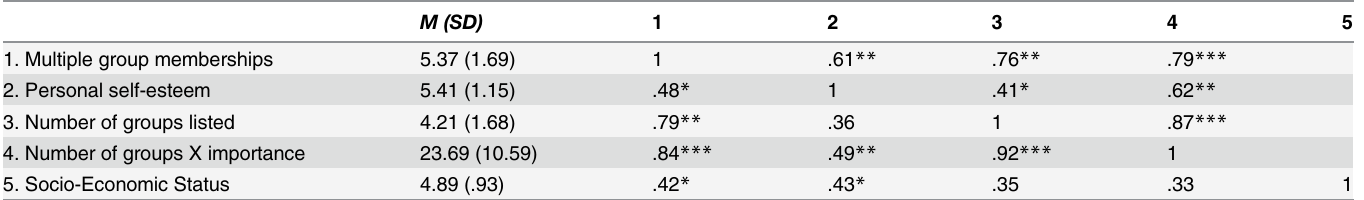
Table 1. Study 1a: Descriptive statistics and bivariate correlations for British